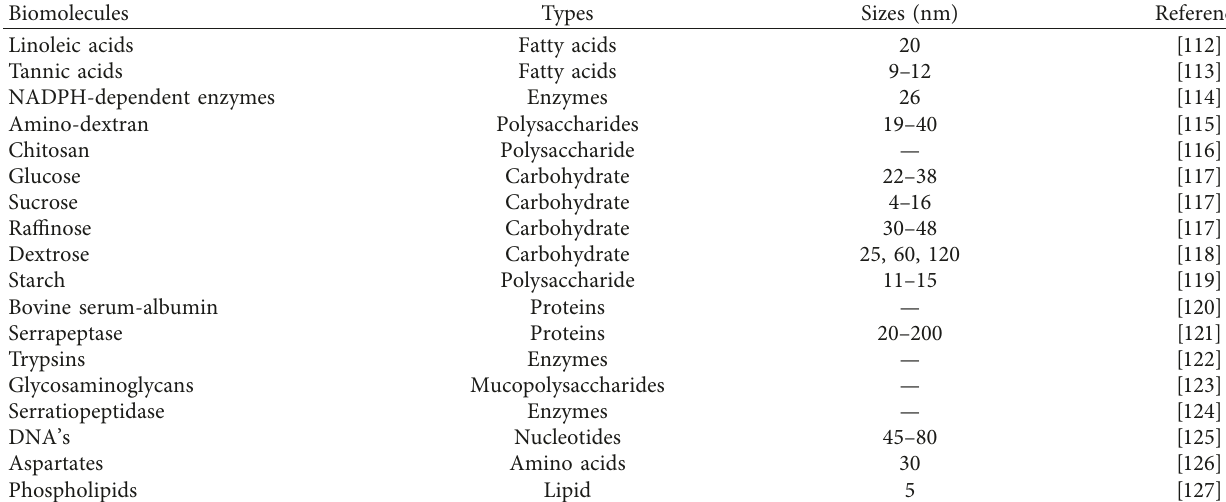
Table 4: List of biomolecules involved in the production of